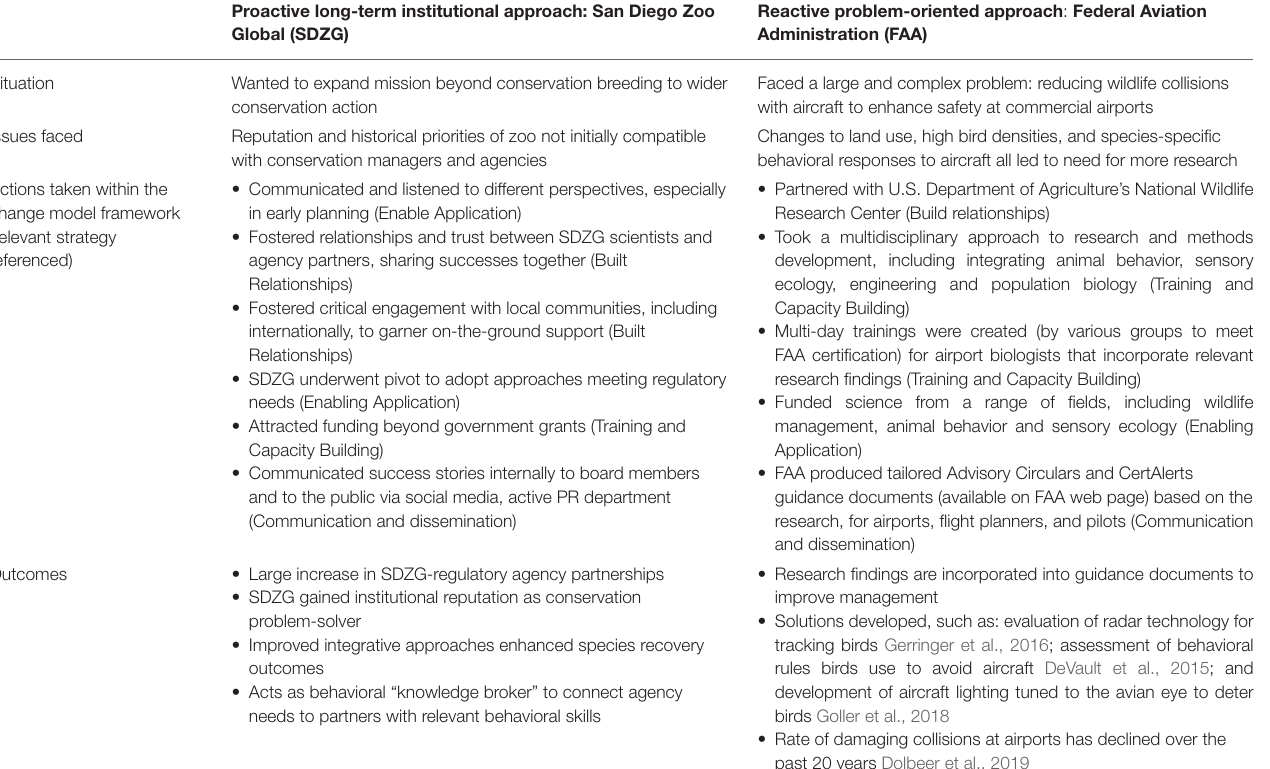
TABLE 3 | Examples and elements of successful integration of evidence-based conservation